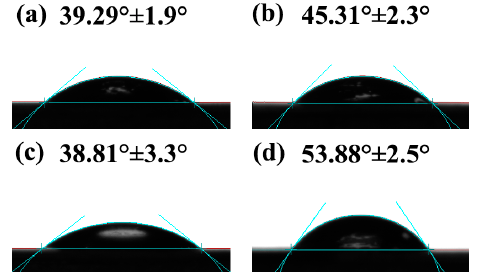
Figure 6. Water contact angles (WCA) of SPI film and SPI-based films modified with graphene, CNC, and PCNC.